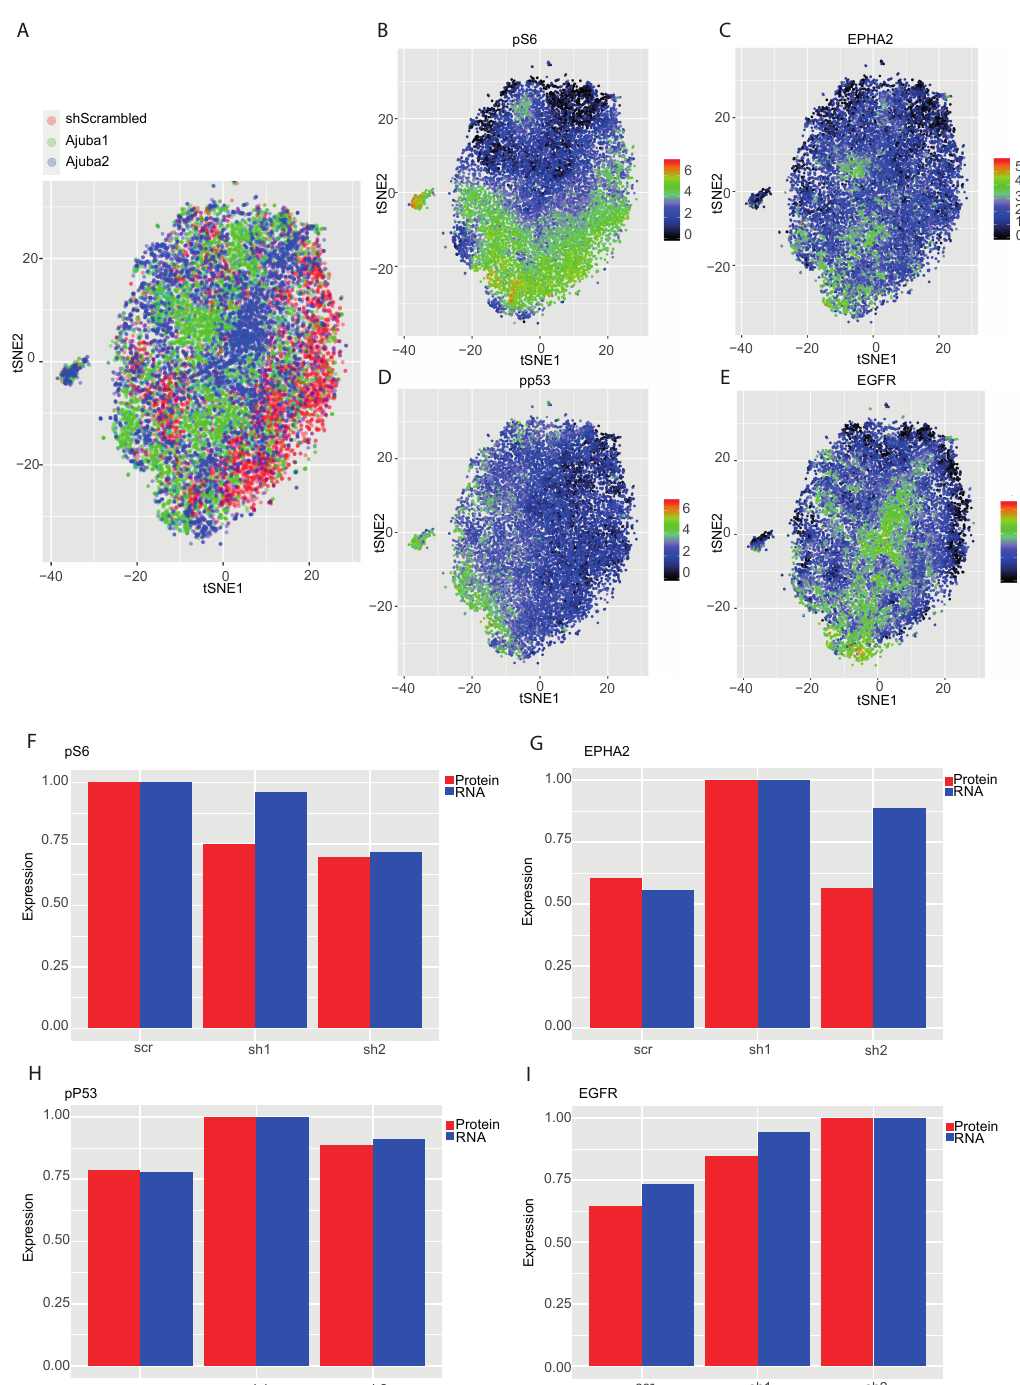
Figure 5. Mass cytometry analysis of Ajuba KD reveals di ff erential expression of cancer associated proteins. ( A ) The t -SNE plots are clustered according to their barcoding and coloured according to the sample they come from. ( B – E ) The t -SNE plots are clustered according to their antigen expression and coloured according to a specific ab expression. All graphs have been displayed using function Rtsne from the R package Rtsne. ( F – I ) Bar graphs displaying correlation between protein and RNA expression. Averaged and normalized RPM values of the RNA-seq and the arcsinh transformed CyTOF data were computed independently and the rescaled values used to compare